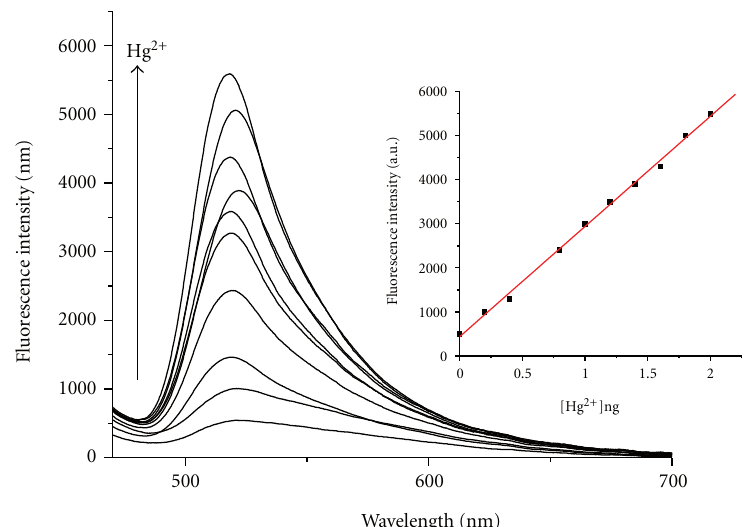
F 2: Fluorescence spectra of 2,�-dichloro�uorescien hydra�ide in presence of variable mercury (II) concentrations